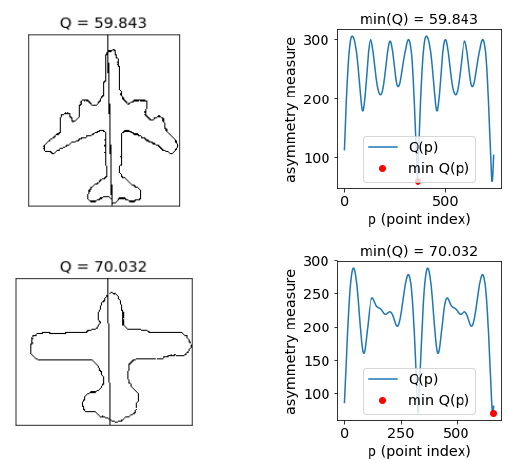
Figure 10. The first column consists of images with the symmetry axises of plane contours. Q is the asymmetry measure. The second column contains the assymetry measure of given contours from different contour